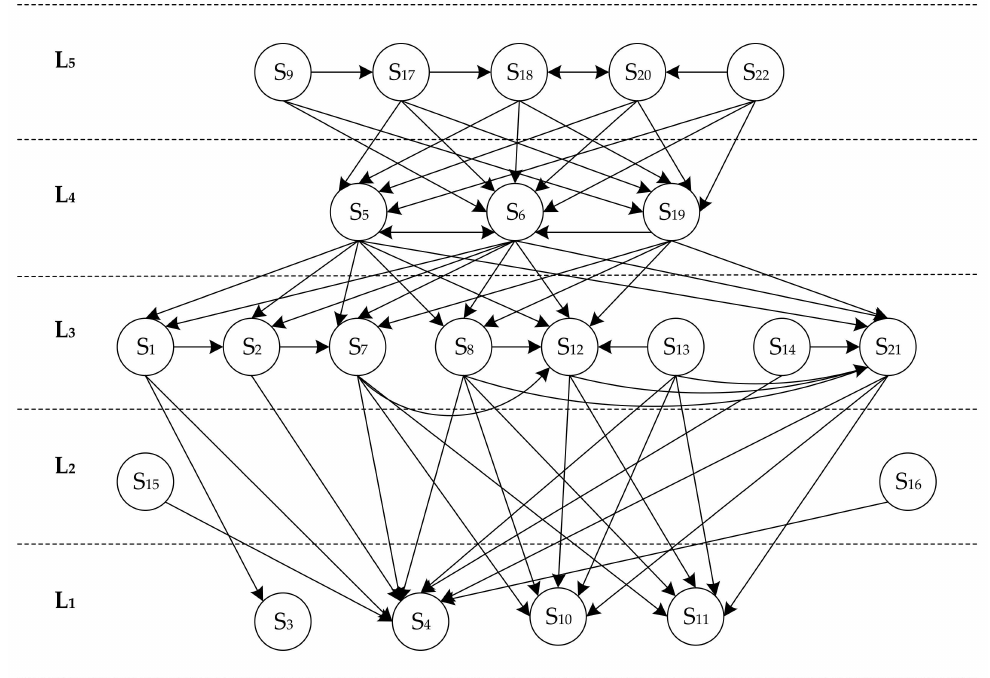
Figure 3. The hierarchical structure model of the influencing